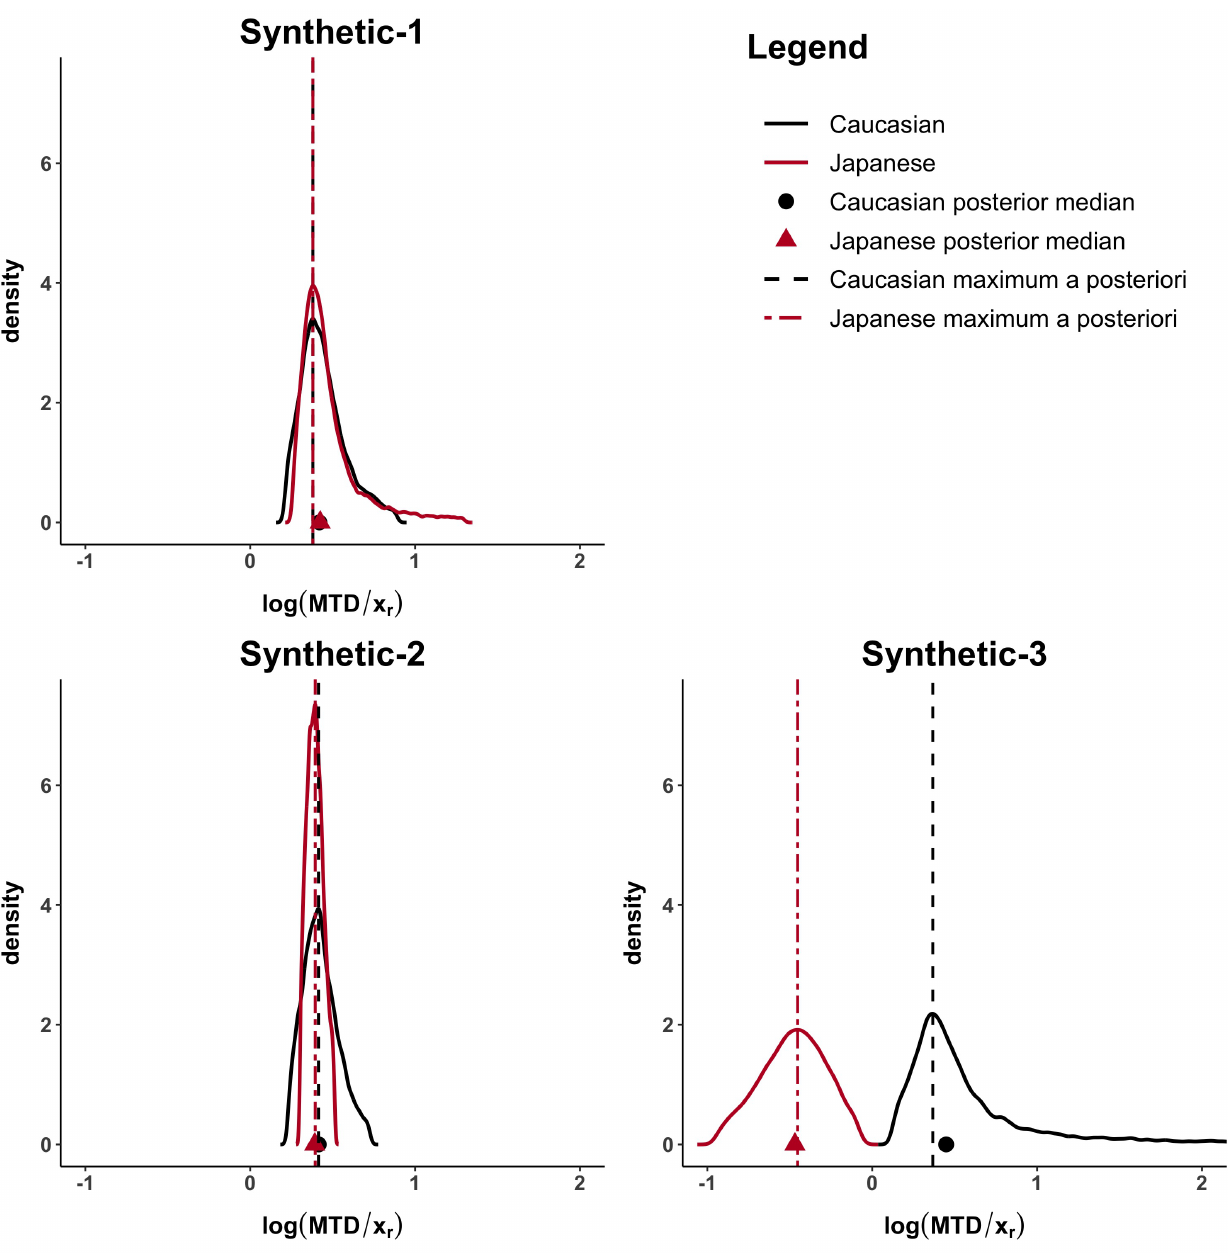
Figure 2. MTD posterior distributions for the Synthetic-1, Synthetic-2 and Synthetic-3 examples. Posterior medians are represented by a circle for Caucasian and a triangle for Japanese, while maximum a posteriori by a dashed line for Caucasian and a two-dash line for